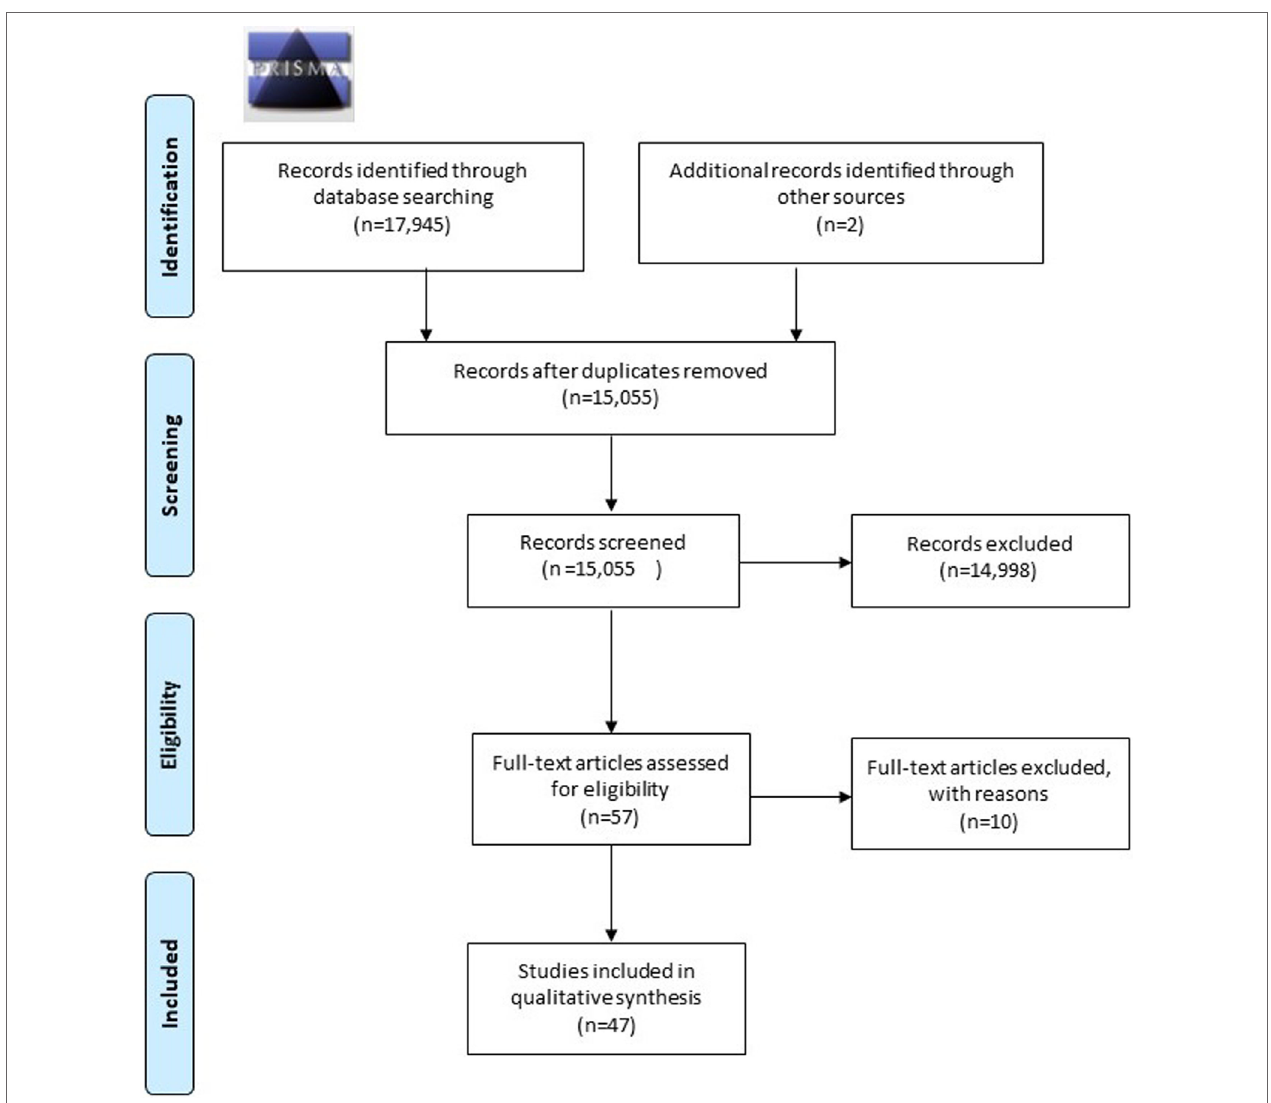
FigURe 2 | Flow diagram with screening process, according to the preferred reporting items for systematic reviews and meta-analyses